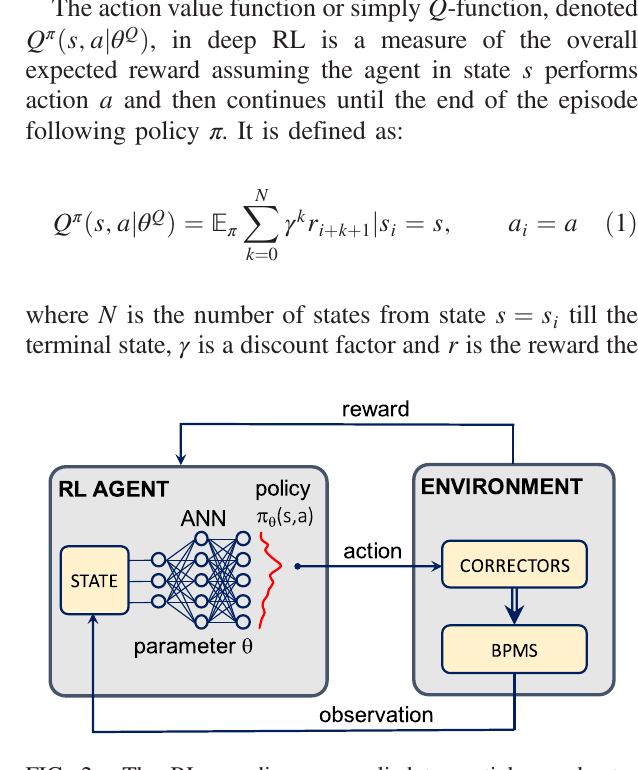
FIG. 2. The RL paradigm as applied to particle accelerator control, showing the example of trajectory